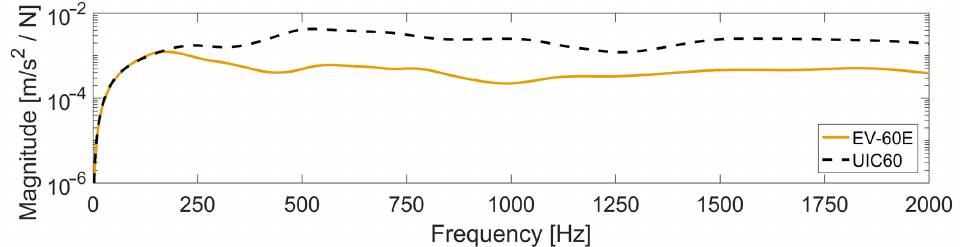
Figure 11. Crossing sleeper accelerance FRF (at sensor position) for the load applied on the crossing rail above the sleeper. Results are shown for two turnout designs, EV-60E, featuring rail fastenings with a soft resilient element between crossing rail and sleepers, and UIC60 with a direct and very stiff connection between crossing rail and sleepers. Nominal ballast parameters were used (see Table 4).